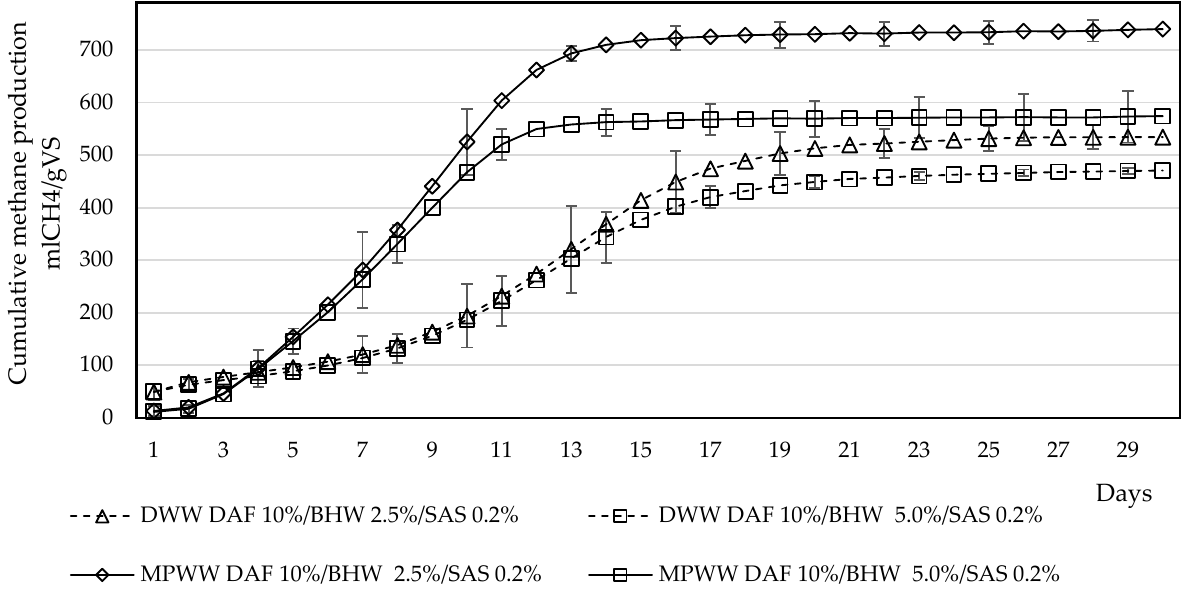
Figure 7. Meat production wastewater (MPWW) DAF sludge together with biomass hydrolysis waste (BHW) co-digestion with anionic surfactant, and dairy wastewater (DWW) DAF sludge with biomass hydrolysis waste (BHW) co-digestion with anionic surfactant 30-day cumulative BMP. A combination of MPWW DAF and DWW DAF with BHW substrate compositions are, in general, showing lower BMP values when compared to other experimental